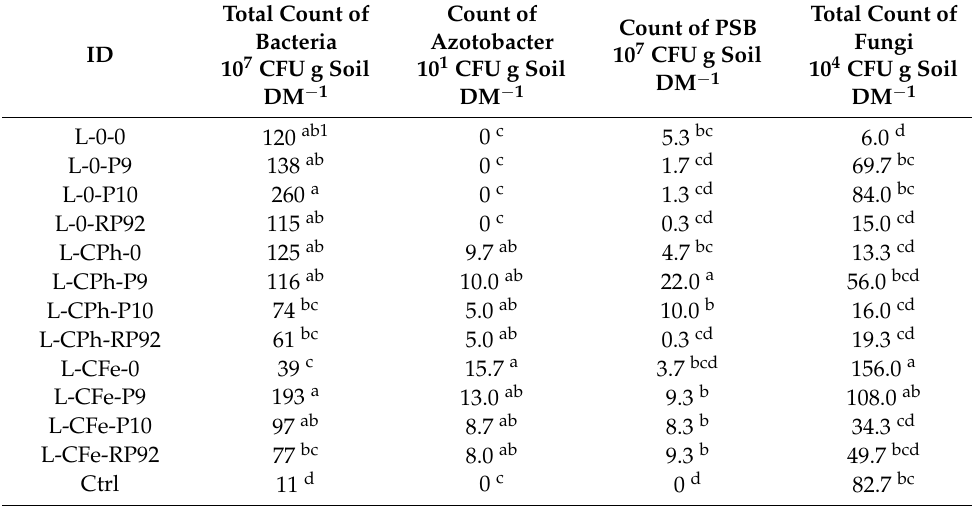
Table 3. Count of cultivable microorganisms, dependent on the remediation treatment